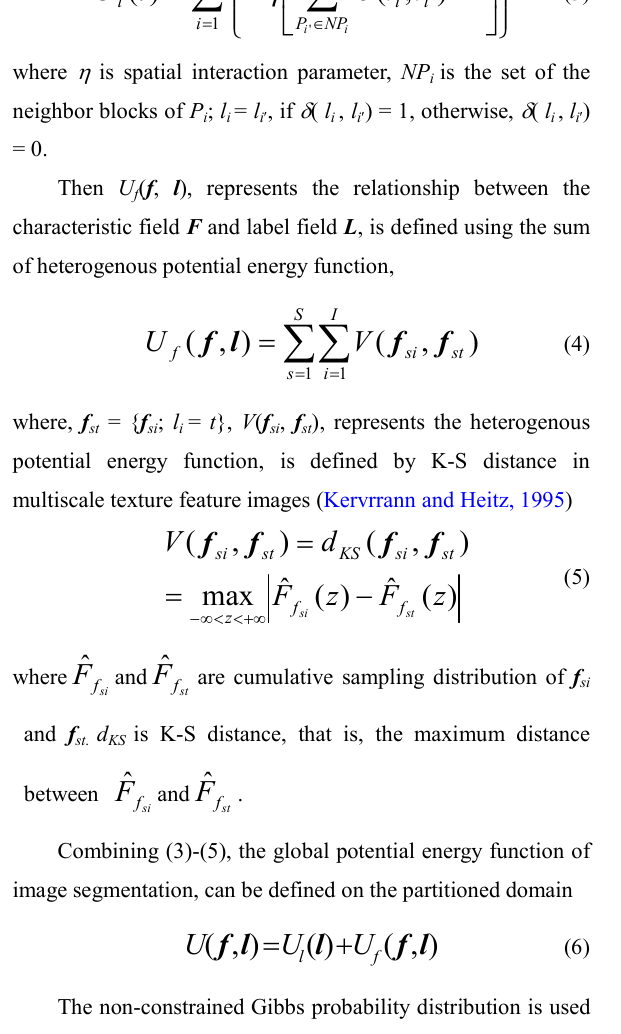
To illustrate the feasibility and superiority of the proposed approach, two real SAR images with 128  128 pixels shown in Figure 1 are tested.